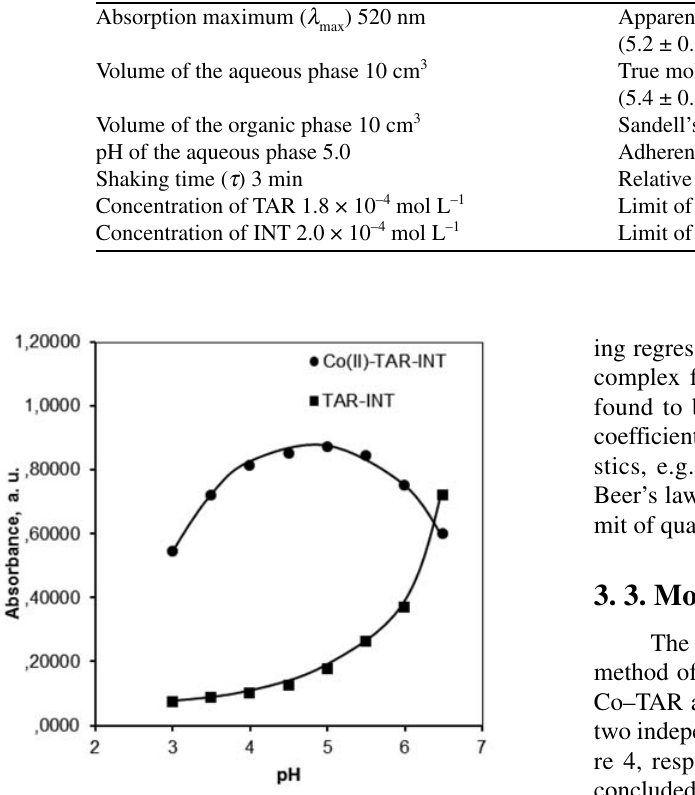
extract and of TAR–INT against CHCl